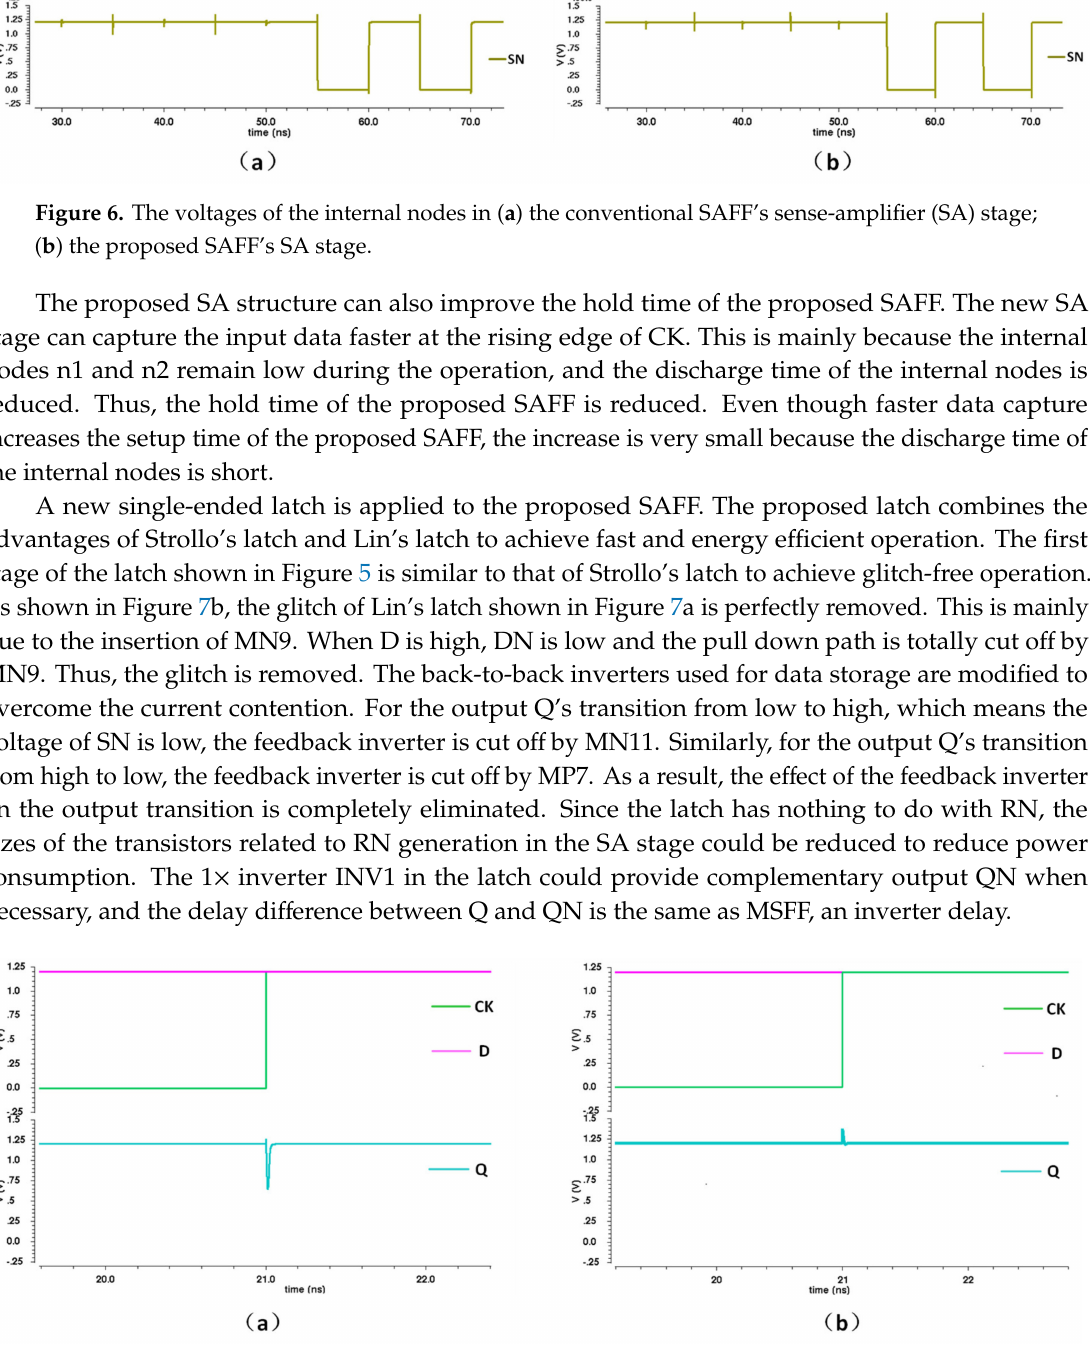
Figure 7. ( a ) Glitches in Lin’s SAFF; ( b ) Glitch-free operation of the proposed